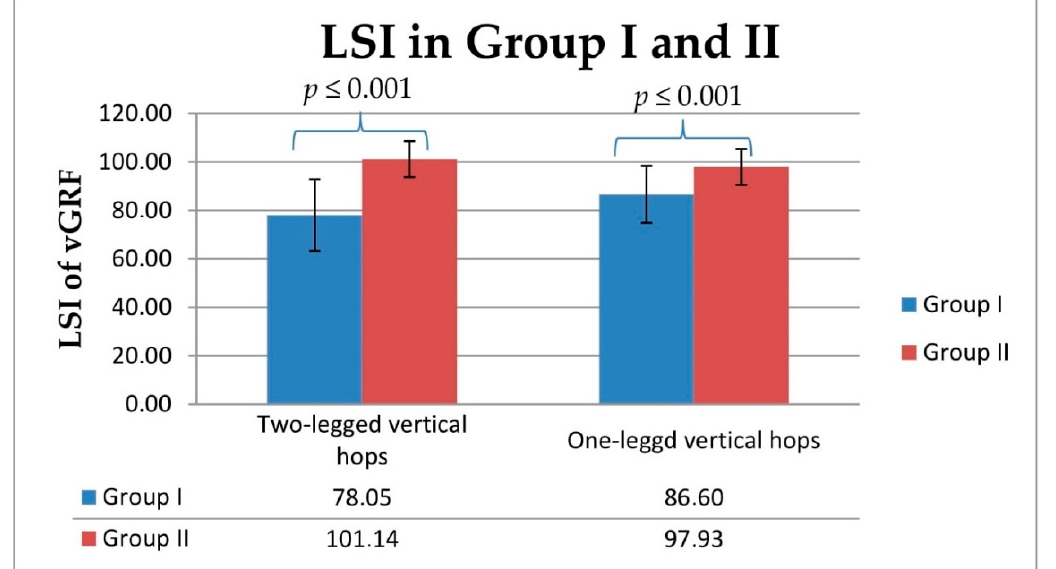
Figure 5. Comparison of the between-group limb symmetry index (LSI) values of the vertical component of ground reaction forces during two- and one-legged vertical hops in Group I and Group II. Statistical significance level ( p ). The between-group ANOVA analysis showed statistically lower relative vertical ground reaction force values obtained from the comparison between the values correspond- ing to operated legs in Group I and the values obtained in Group II for right and left legs during one- and two-legged vertical hops ( p ≤ 0.001; Table 3). Tukey’s test revealed signifi- cantly lower relative vertical ground reaction force values for operated legs compared to those corresponding to right and left legs in Group II, obtained during one-legged vertical hops ( p ≤ 0.001; Table 3) and two-legged vertical hops ( p ≤ 0.001; Table 3). There were no significant differences between right and left legs in Group II in one-legged vertical hops ( p = 0.913; Table 3) or two-legged vertical hops ( p = 0.981 Table